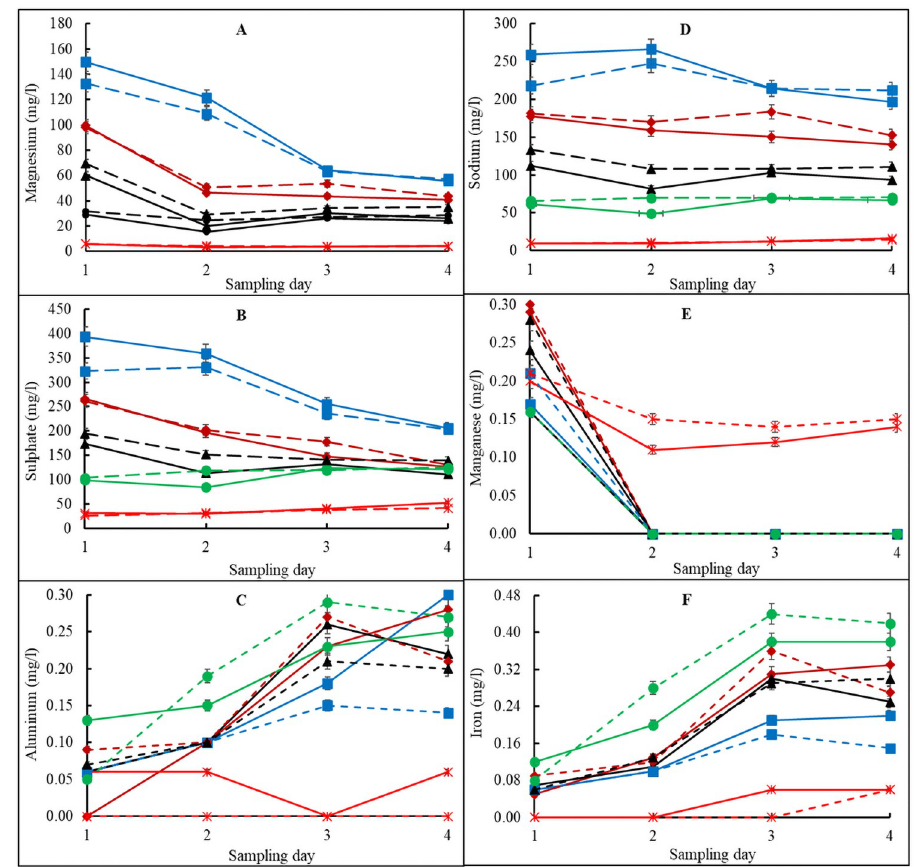
Fig 4. Magnesium (A), sulphate (B), aluminum (C), sodium (D), manganese (E) and iron (F) availability in vermicast-sawdust mixed media without (solid lines) and with (broken lines) addition of Trichoderma viride during a 90-day incubation period. A1, B1 (blue line) is 80%vermicast+20%sawdust; A2, B2 (brown line) is 60% vermicast+40%sawdust; A3, B3 (black line) is 40%vermicast+60%sawdust; A4, B4 (green line) is 20%vermicast+ 80% sawdust; and A5, B5 (red line) is sawdust alone. Day 0 (point 1); day 30 (point 2); day 60 (point 3) and day 90 (point 4) with n = 3 per experimental replicate. Error bars represent standard